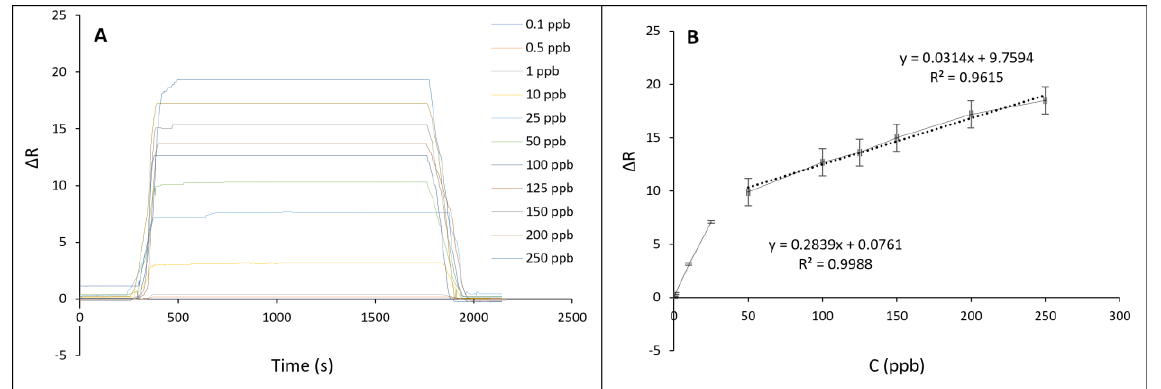
Figure 5. ( A ) Sensorgrams of coumaphos detection by the designed CIP-SPR nanosensor in different concentrations (pH: 7.4). ( B ) Standard calibration curve for coumaphos detection by designed CIP-SPR nanosensor in different concentrations (0.10–250 ppb, pH: 7.4).